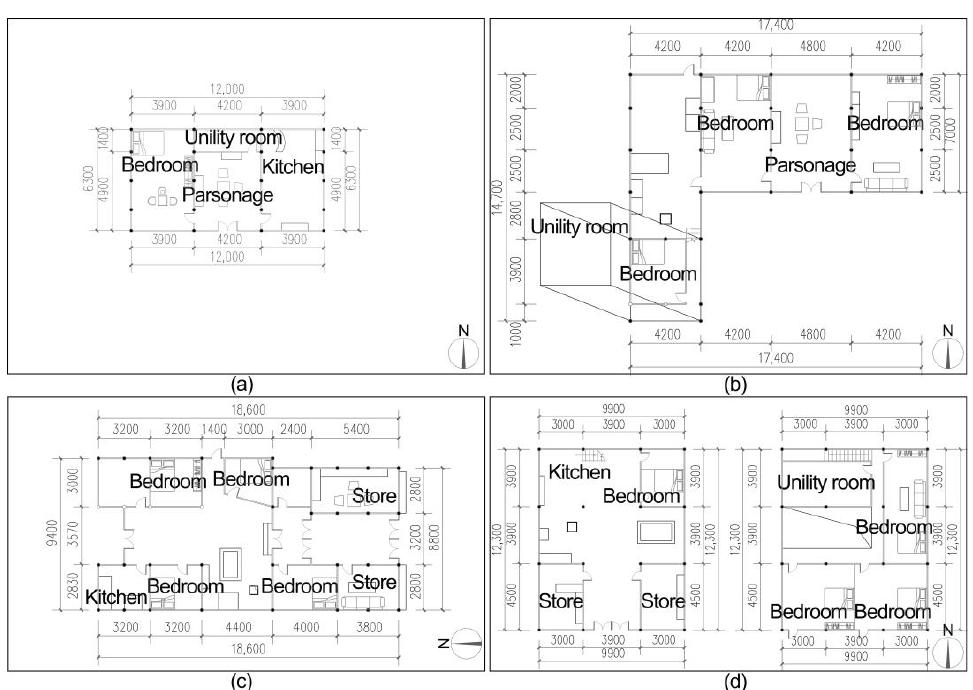
Figure 3. Four representative dwelling planes of the ancient towns in Xiangxi Tujia. ( a ) L-shape dwelling [34], ( b ) Zuozi dwelling [34], ( c ) front store and back house dwelling, ( d ) lower store and upper house dwelling.